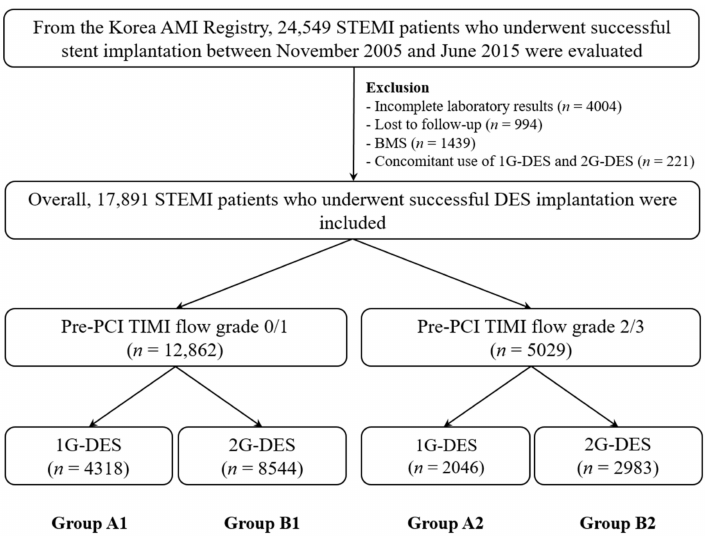
Figure 1. Flowchart. AMI, acute myocardial infarction; STEMI, ST-segment elevation myocardial infarction; BMS, bare-metal stent; 1G-DES, first-generation drug-eluting stent; 2G-DES, second- generation DES; Pre-PCI, pre-percutaneous coronary intervention; TIMI, thrombolysis in myocar- dial